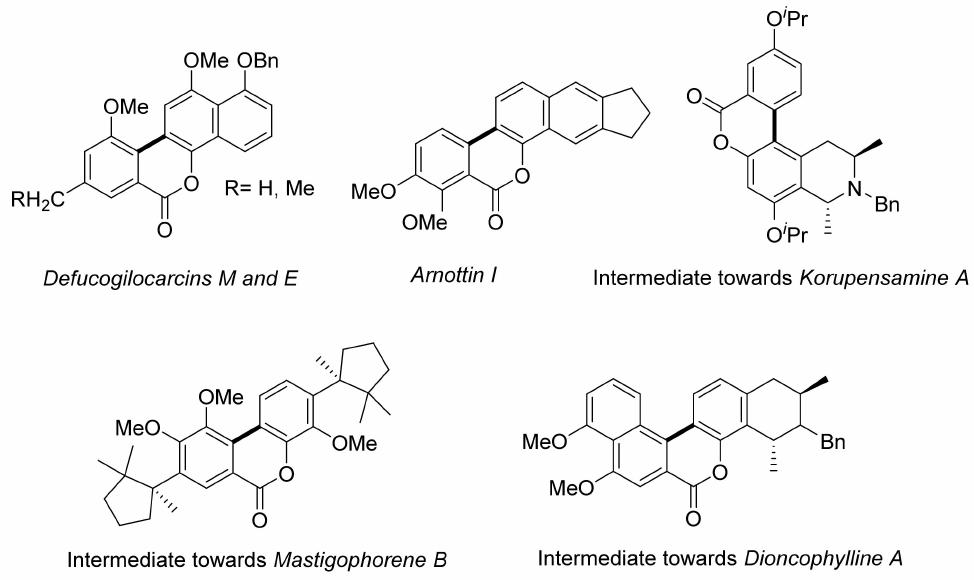
Figure 2. Natural products and synthetic precursors obtained via direct